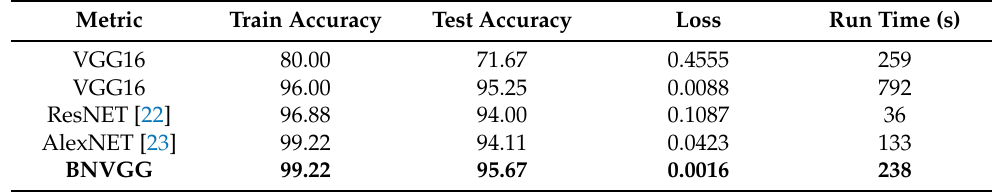
Table 2. Algorithm performance